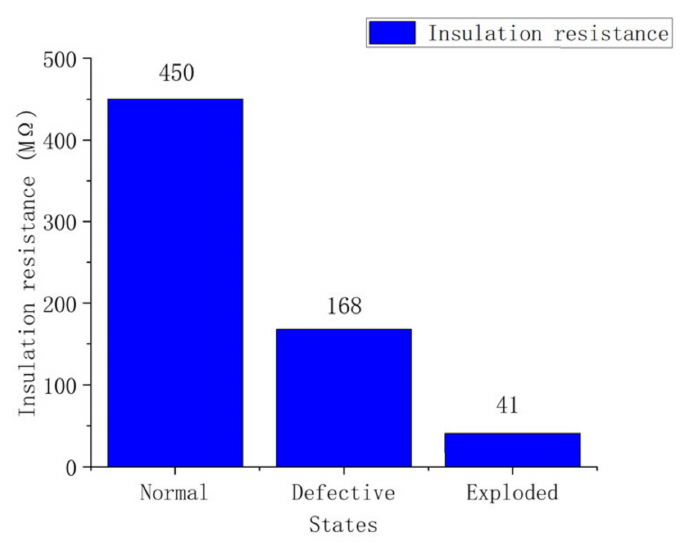
Figure 11. Insulation resistance of different states